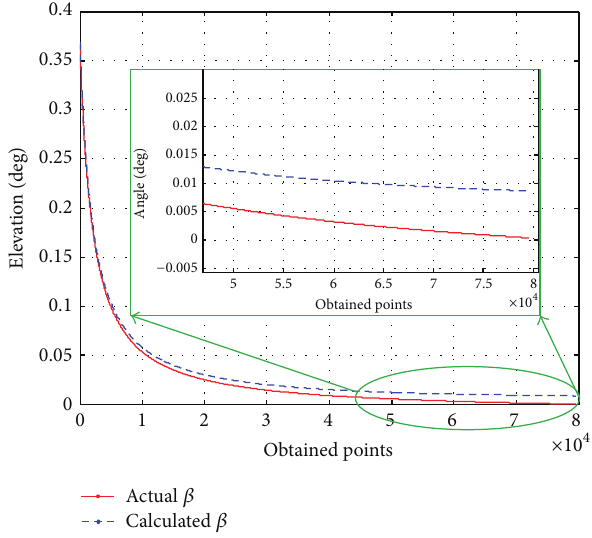
Figure 8: The variation of the actual elevation, 𝛽 , which is geo- metrically determined, and the calculated 𝛽 (calculated using time